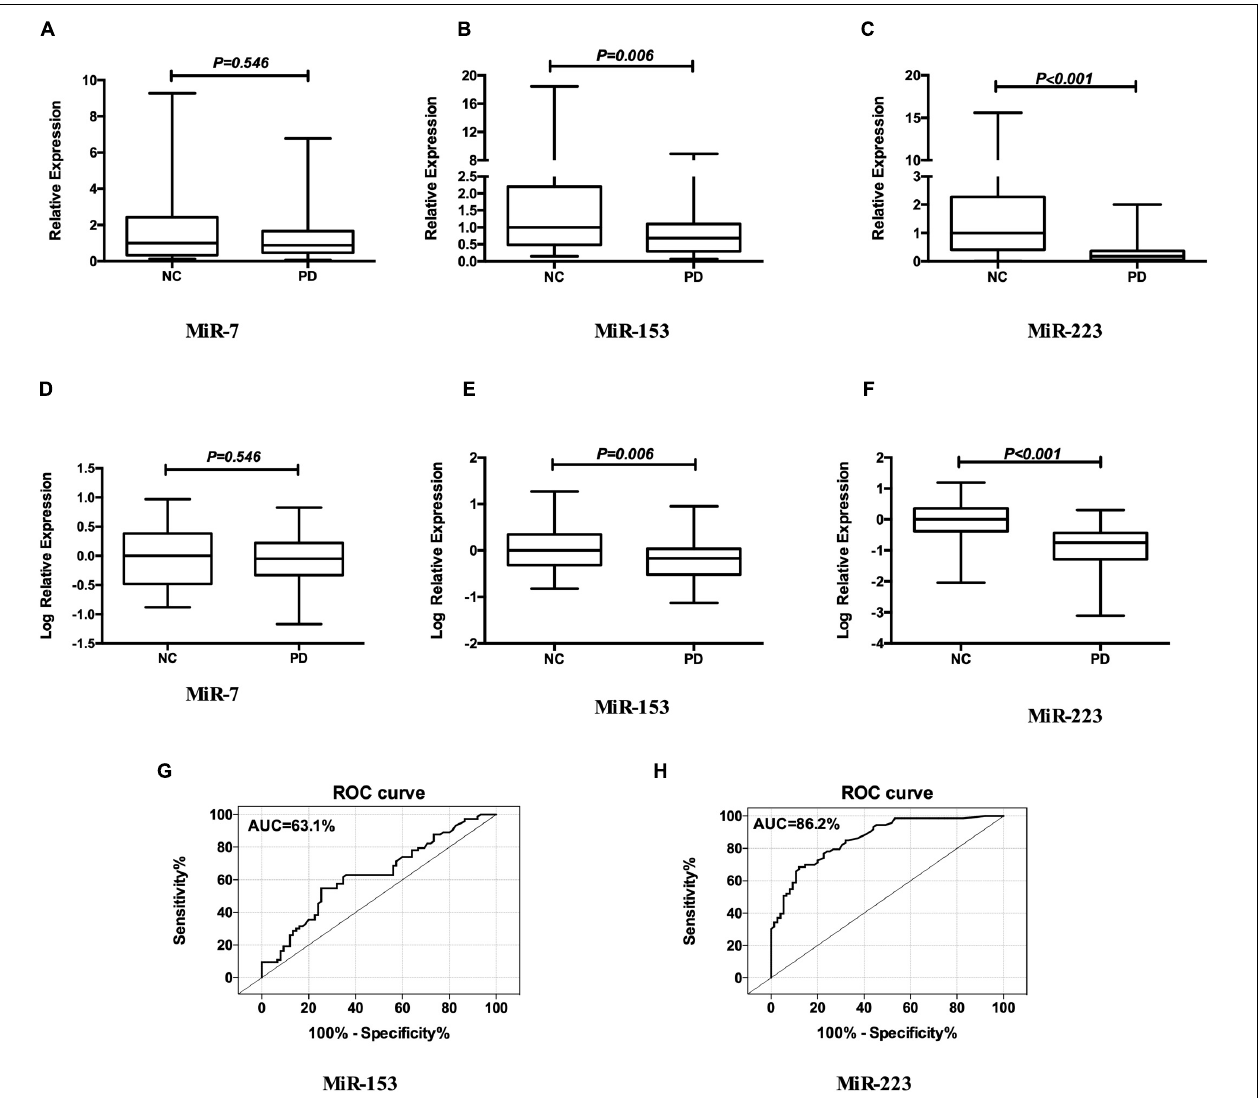
FIGURE 1 | MiR-7, MiR-153, and miR-223 levels in the plasma of patients with PD relative to NCs. Mean expression levels of miR-7 (A) , miR-153 (B) , and miR-223 (C) were determined by real-time quantitative polymerase chain reaction and analyzed using the delta-delta cycle threshold value (2 - (cid:49) (cid:49) Ct ) method. Data were normalized via log transformation and reported for miR-7 (D) , miR-153 (E) , and miR-223 (F) . Midline in box and whisker plots depicts the median, with upper and lower limits representing maximum and minimum values, respectively. ROC curves were estimated for miR-153 (G) and miR-223 (H) , with AUC indicated. n = 73 and 75 for NCs and PD groups, respectively. AUC, area under the curve; NCs, normal controls; miR, microRNA; PD, Parkinson’s disease; ROC, receiver operating